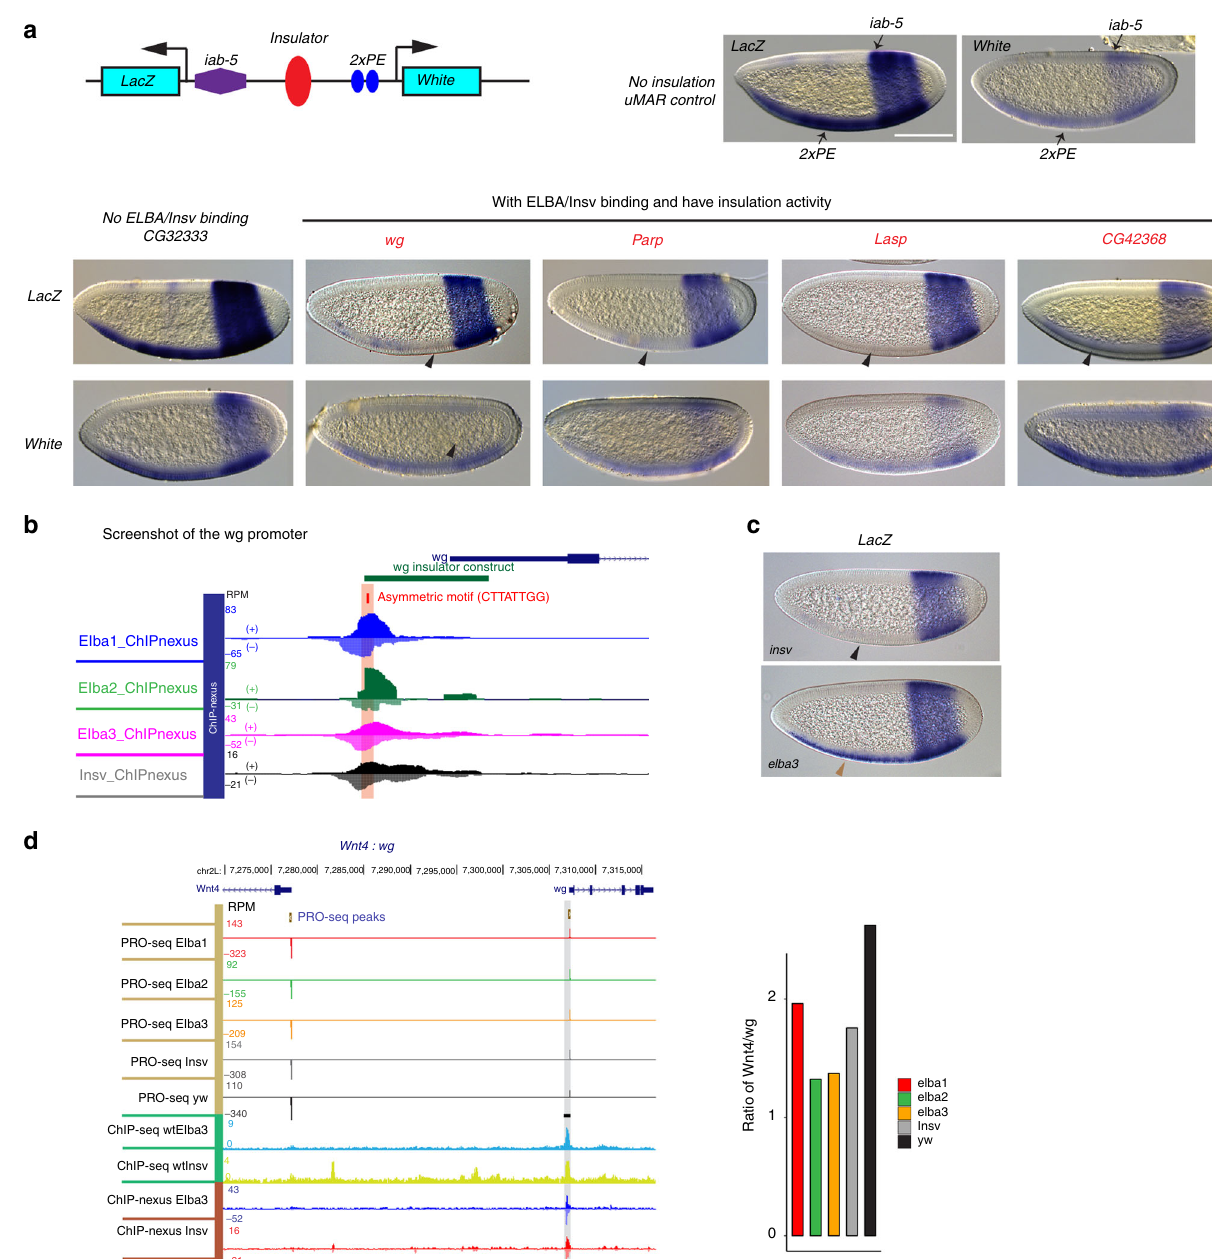
Fig. 7 ELBA is required for separating transcription of Wnt4 and wg . a Transgenic insulator assay. In situ hybridization images show expression of the lacZ and white genes driven by the 2xPE and iab-5 enhancers in the ventral and the posterior stripes, respectively. An inserted control fragment ( uMAR ) does not affect the reporter expression, neither does the CG32333 fragment that has no Elba or Insv binding. The fragments from the wg , Parp , and Lasp loci, highlighted in red, show blocking activity, evidenced by loss of the ventral stripe expression of LacZ . The iab-5 enhancer was less affected, with a weaker but visible posterior stripe of white . Black arrowheads indicate the weakened or lost staining by insulation activity of the inserted fragments. b A screenshot of the insulator in the wg locus with ELBA and Insv binding and an asymmetric Insv/ELBA motif. c The lacZ staining shows loss of insulation activity of the wg element in elba3 , but not insv mutant embryo. The black arrowhead indicates the absence of the ventral stripe. The brown arrowhead indicates recovery of the ventral stripe due to loss of insulation in the elba3 mutant. d A screenshot of the divergent pair Wnt4 and wg with an Elba/Insv peak proximal to the wg promoter. The ratio of PRO-seq promoter expression of Wnt4 versus wg decreased in the mutants compared with wt. Scale bar: 100 µ